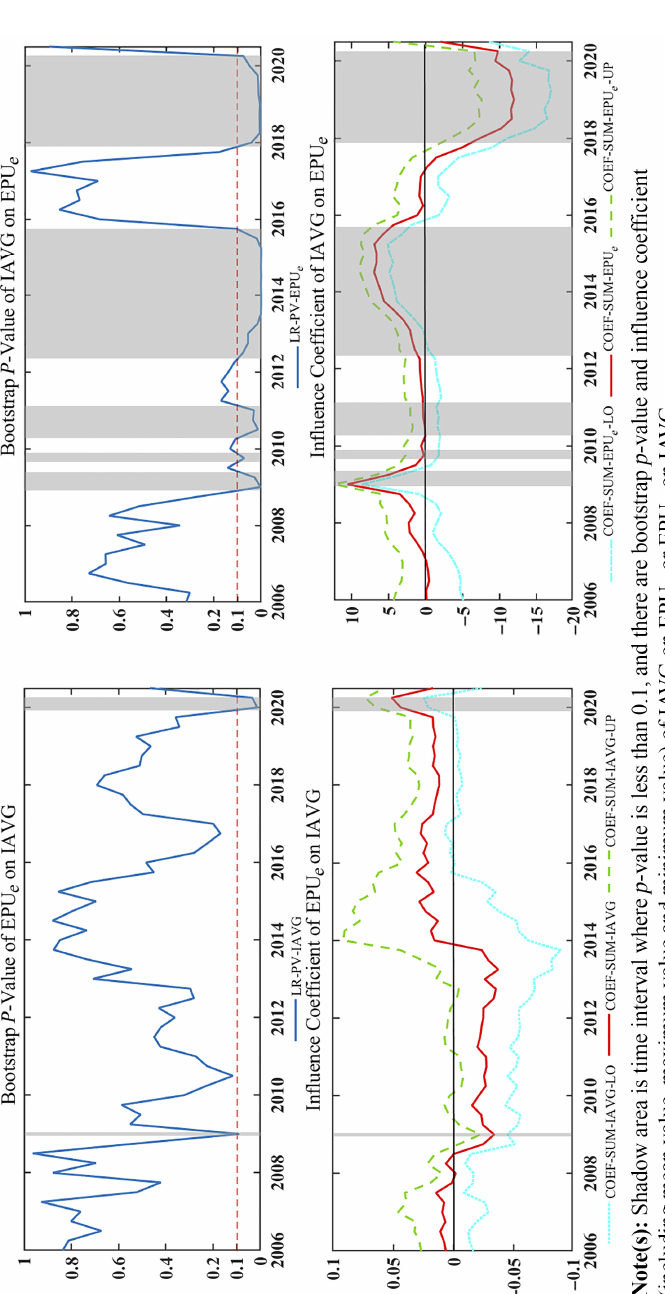
Figure 6. Sub-sample bootstrap rolling window causality test of EPU e and